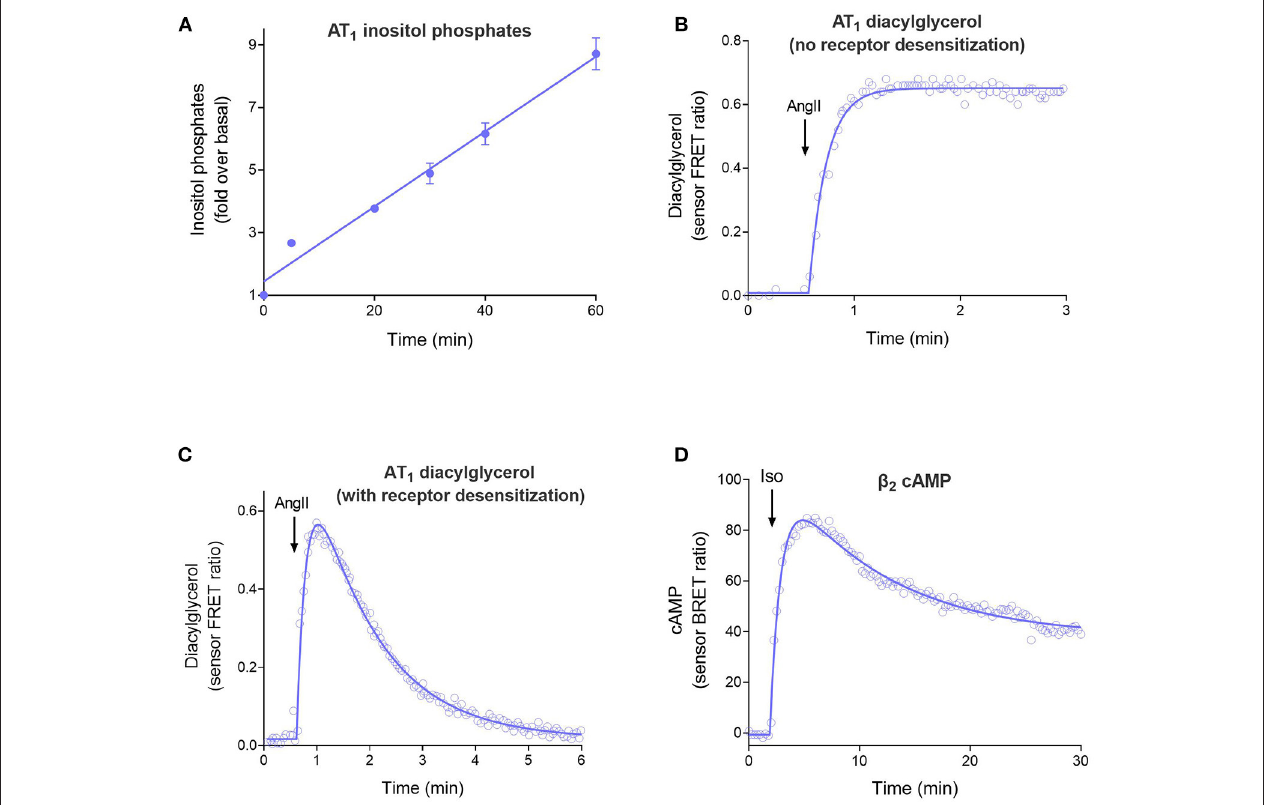
FIGURE 2 | The four time course curve shapes for GPCR signaling. Almost all signaling time course data can be described by one of the four shapes shown here. The shape is determined by the regulation of signaling mechanisms in operation in the assay system (Hoare et al., 2020b). (A) Straight line time course, exemplified by inositol phosphates accumulation stimulated by angiotensinII (Ang II) via the AT 1 angiotensin receptor ( Kohout et al., 2001). Note there is no regulation of signaling in operation in the cells; receptor desensitization was blocked by the use of arrestin knock-out cells, and degradation of the inositol phosphates signal was blocked using LiCl. (B) Rise to steady-state curve, exemplified by AT 1 receptor-stimulated diacylglycerol (DAG) production ( Violin et al., 2006a). This curve results from a single regulation of signaling mechanism, in this case clearance of the DAG signal by DAG kinases. (Desensitization was blocked using a mutant receptor). (C) Rise and fall to baseline curve, exemplified by exemplified by AT 1 receptor-stimulated DAG production via the wild-type receptor. This shape results when two regulation of signaling mechanisms are operative, in this case DAG degradation and receptor desensitization. (D) Rise and fall to steady-state curve, exemplified by β 2 adrenoceptor-stimulated cAMP production (Thomsen et al., 2016). This mechanism results from more complex mechanisms, in this case likely involving receptor resensitization as well-desensitization (Hoare et al.,